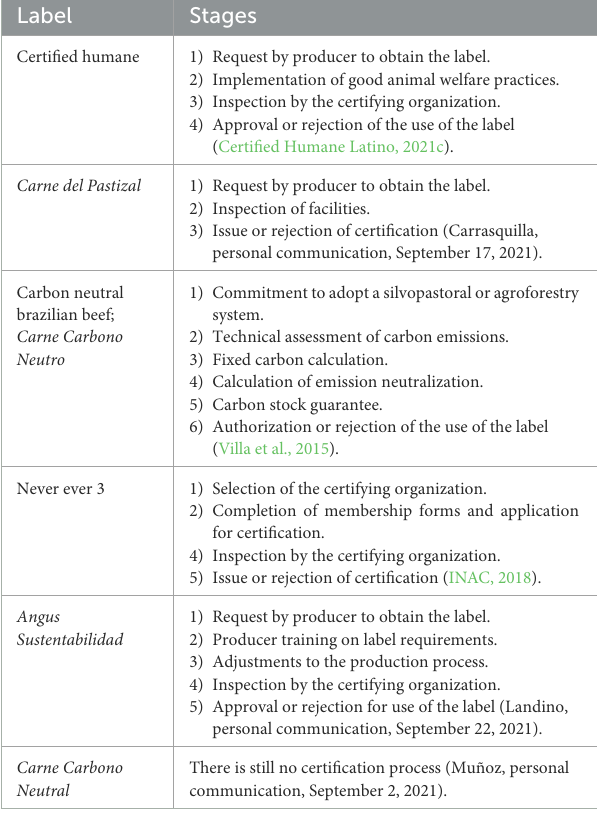
TABLE 4 Stages of the certification